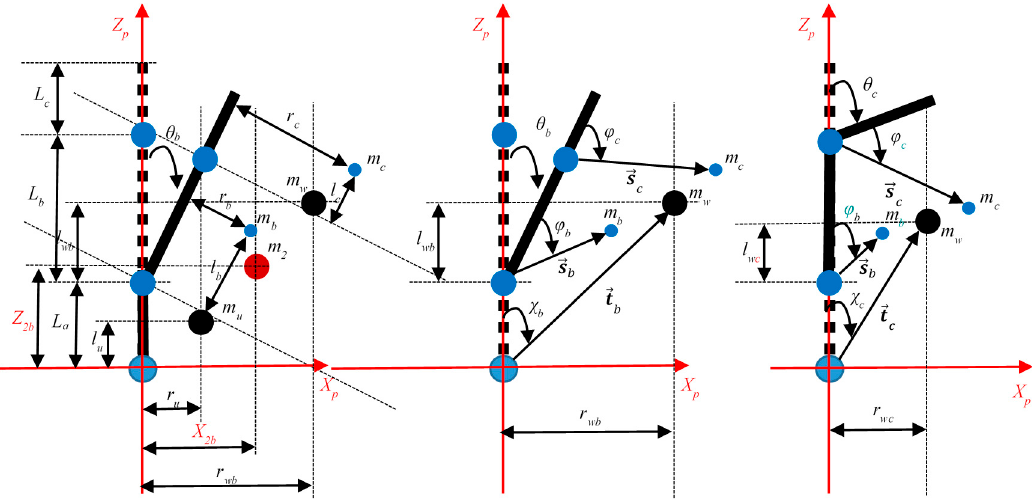
Figure 5. Example for implementing the formula.